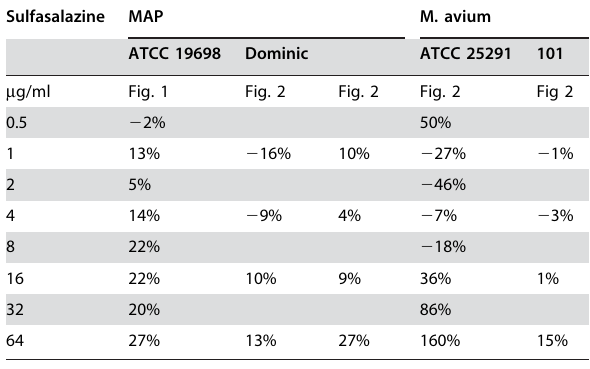
Table 5. Test Agents: 5-ASA + Sulfapyridine ... ... ... .... ... ... .... ... ... .... ... ... .... ... ... .... ... ... .... ... ...